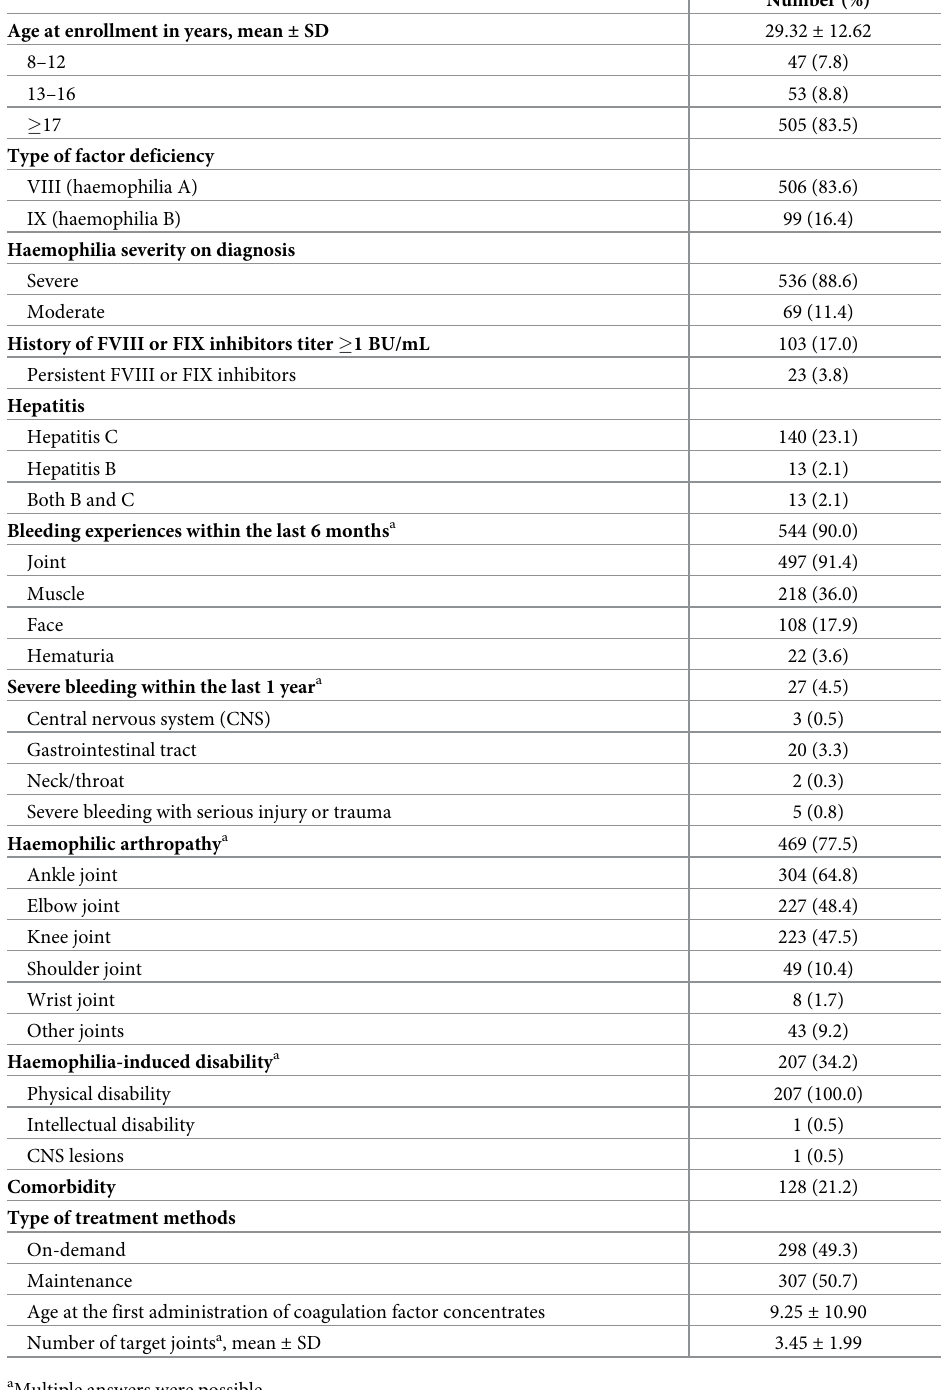
Table 1. Demographic and clinical characteristics of the